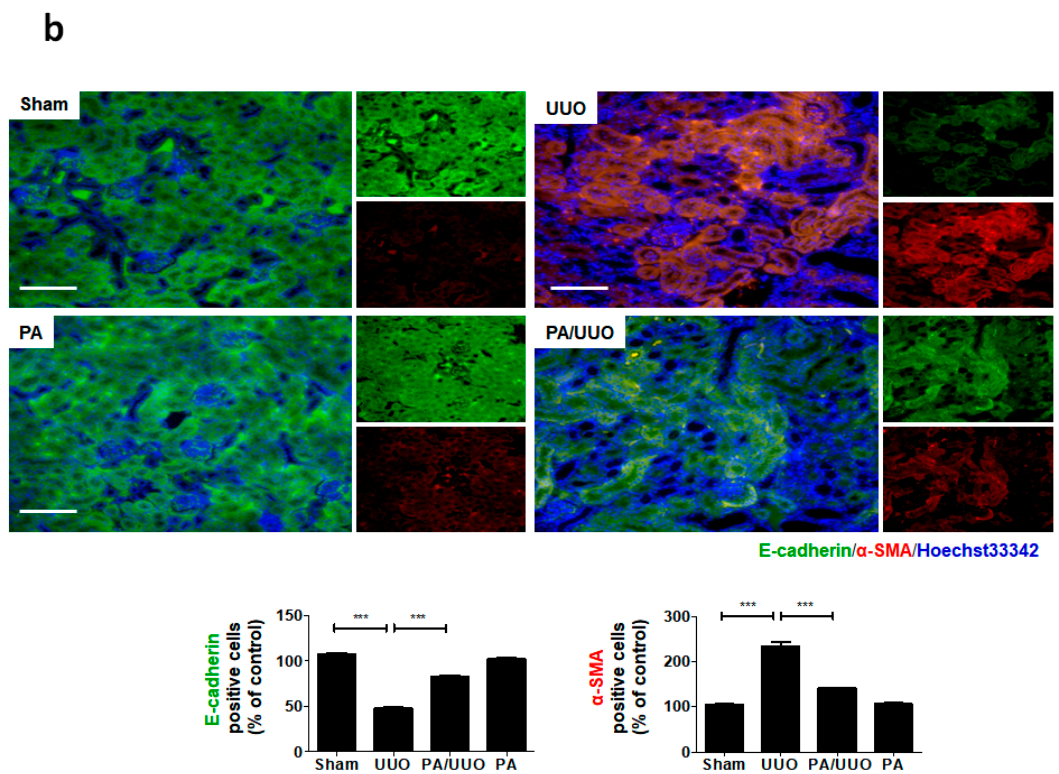
Figure 3. Effect of PA on E-cadherin and α -SMA expression in UUO mice. ( a ) Immunoblot results show the effects of PA on the inhibition of UUO-induced changes in EMT markers, including E-cadherin and α -SMA. β -Actin was used to confirm equal sample loading. ( b ) Immunofluorescence double staining for E-cadherin (green) and α -SMA (red) localization. Cells were counterstained with Hoechst 33342 (blue). Scale bar 100 µ m. The data are representative of three independent experiments and quantified as mean values ± SEM. Tukey’s multiple comparison test, * p < 0.05, ** p < 0.01, *** p < 0.001 compared to control.